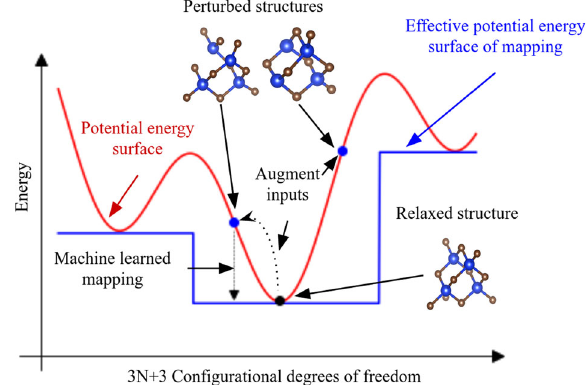
Fig. 1 Data augmentation for learning the potential energy surface (PES). The red line denotes a 2D representation of the continuous PES of materials. The blue line illustrates the effective PES, which describes the energy of a relaxed structure for a given unrelaxed input structure. Data augmentation aims to improve the machine learning of this effective PES by better sampling the con fi guration space. The black circle indicates the relaxed structures contained in the dataset, and the blue circles symbolize arti fi cially generated structures for the data